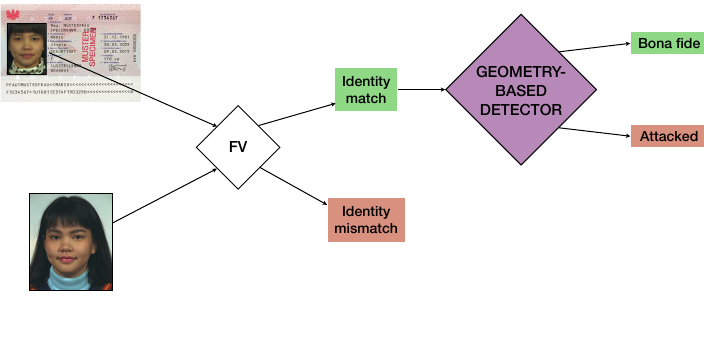
Figure 3. Detection framework.